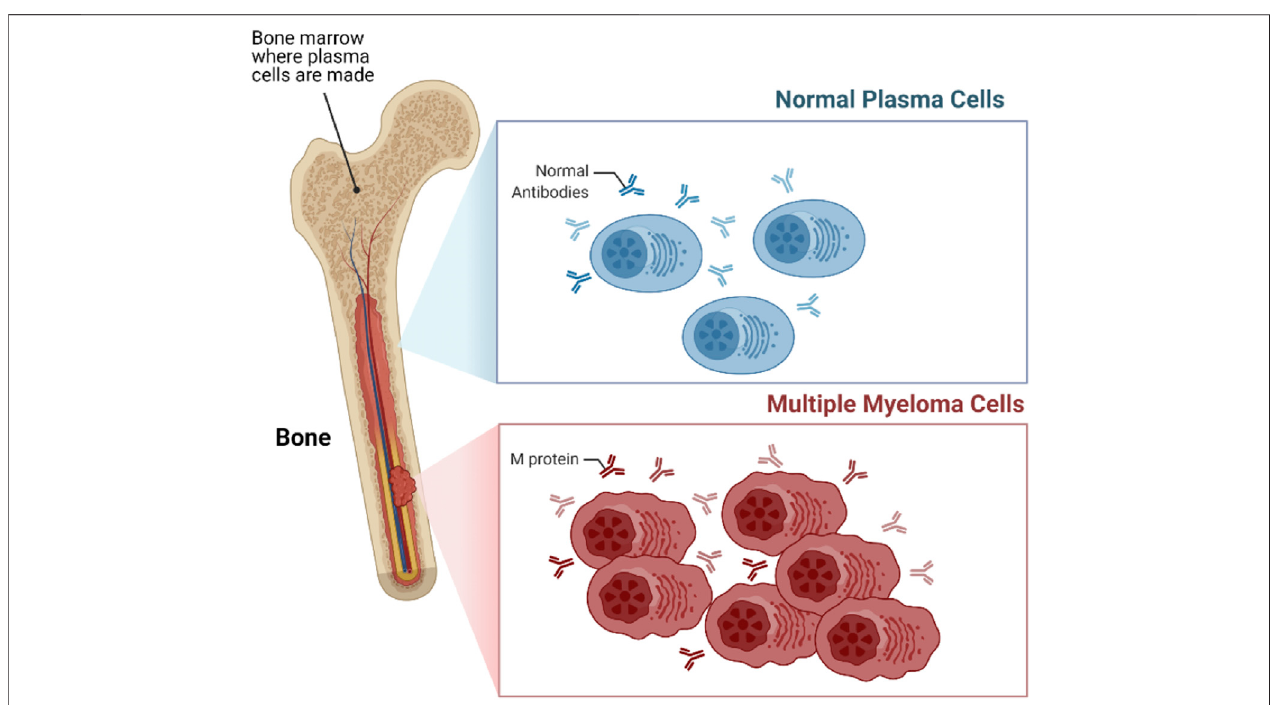
FIGURE 1 | Multiple myeloma (MM). MM is a type of blood cancer that initiates from the bone marrow (BM), arising from the aberrant proliferation of plasma cells.